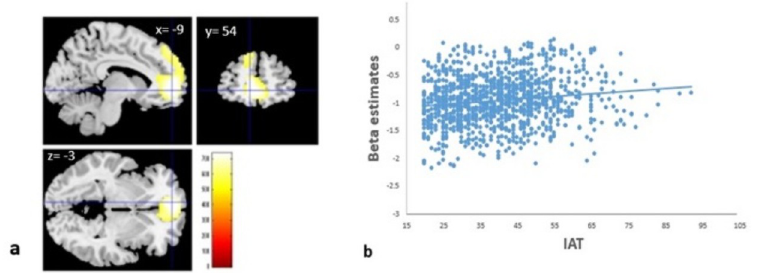
Fig 5. (a) Regional brain activity correlates with internet addiction tendency (IAT) scores. Regions with significant correlations between brain activity and IAT scores are overlaid on a single subject T1 image from SPM8. Results were obtained using a threshold of threshold-free cluster enhancement (TFCE) of p < 0.05 based on 5,000 permutations. IAT scores were significantly and positively correlated with brain activity during the 2-back task in the default-mode network (medial frontal gyrus and anterior cingulum). (b) Scatterplot of the relationship between the IAT scores and brain activity during the 2-back task in the default-mode network. IAT showing a positive correlation with regional brain activity in men (r = 0.113, p = 0.003) and in women (r = 0.177, p =